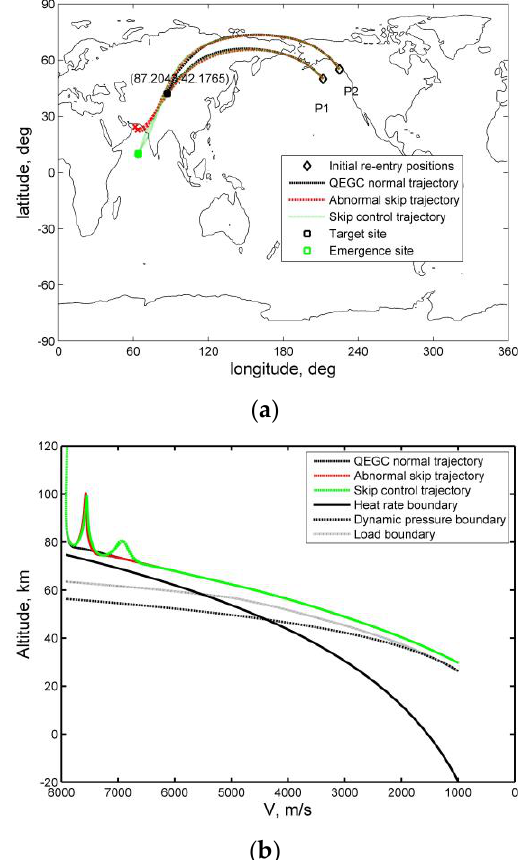
Figure 13. Emergency re-entry of a maneuvering vehicle for normal and abnormal trajectory control: ( a ) lateral histories for normal and abnormal re-entry trajectories, ( b ) velocity–altitude histories for normal and abnormal re-entry trajectories.